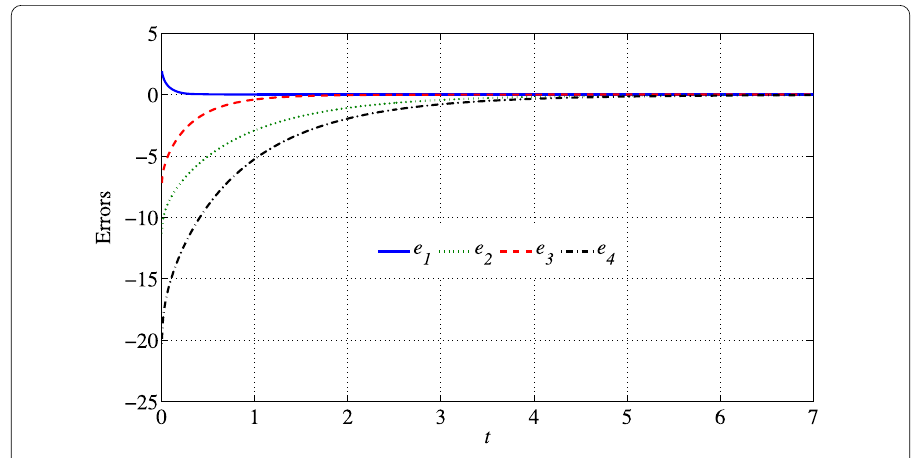
Figure 3 Time series of the synchronized error signals between the master system (12) and the slave system (13) in 4D.